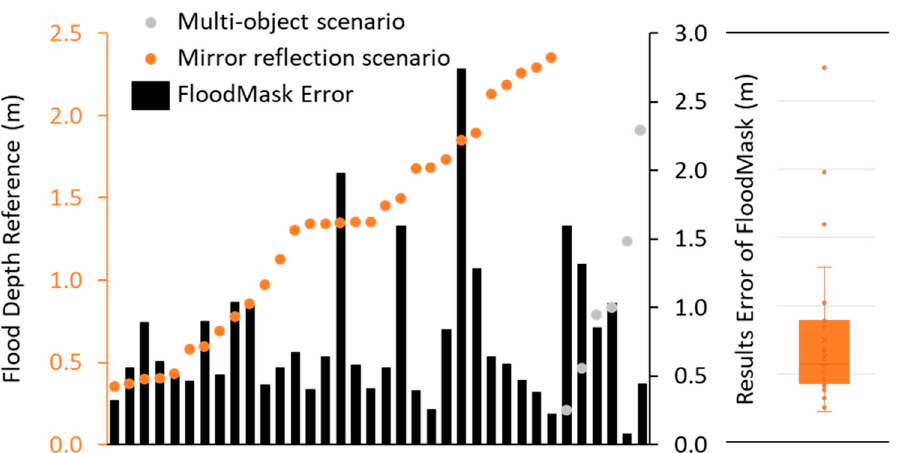
Figure 11. Visual perception flood depth reference data and the error of the FloodMask results with a boxplot in the multi-object scenario.